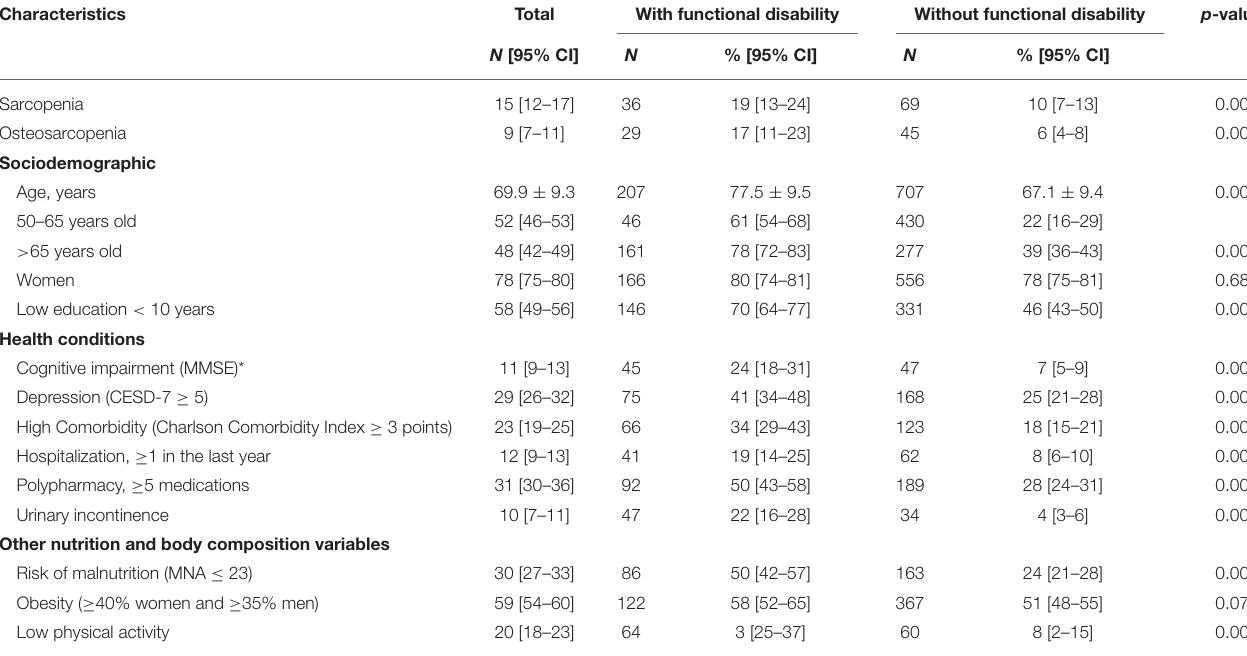
TABLE 2 | Characteristics of participants by functional disability.